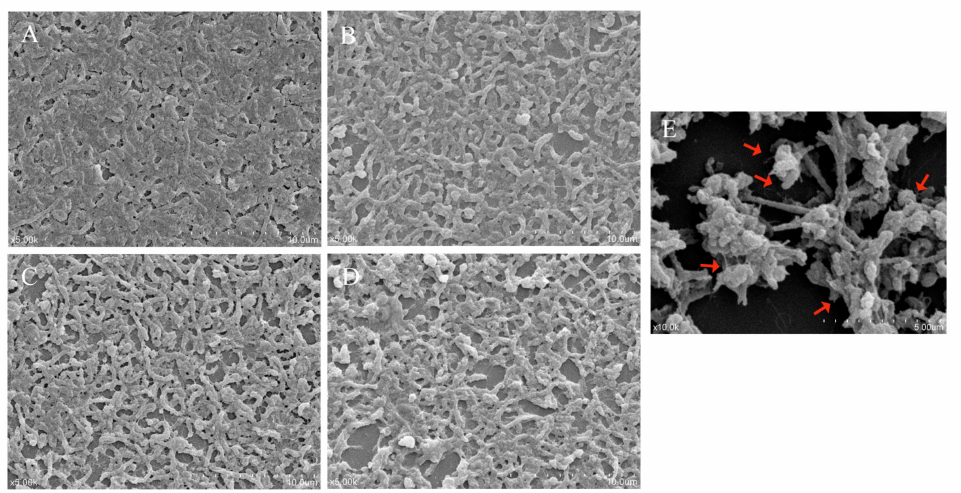
Figure 5. SEM of H. pylori 3192 biofilm on the coverslip. ( A , E ): Control, ( B ): 1 × FIC of AMX and CLR treatment, ( C ): 1/2 × MIC of LN12 CFS treatment, ( D ): 1/2 × MIC of LN12 CFS in combination with 1 × FIC of AMX and CLR treatment. The magnification is 5000 × for A – D , the scale bar is 10.00 µ m; 10,000 × for E , and the scale bar is 5.00 µ m. AMX: Amoxicillin, CLR: